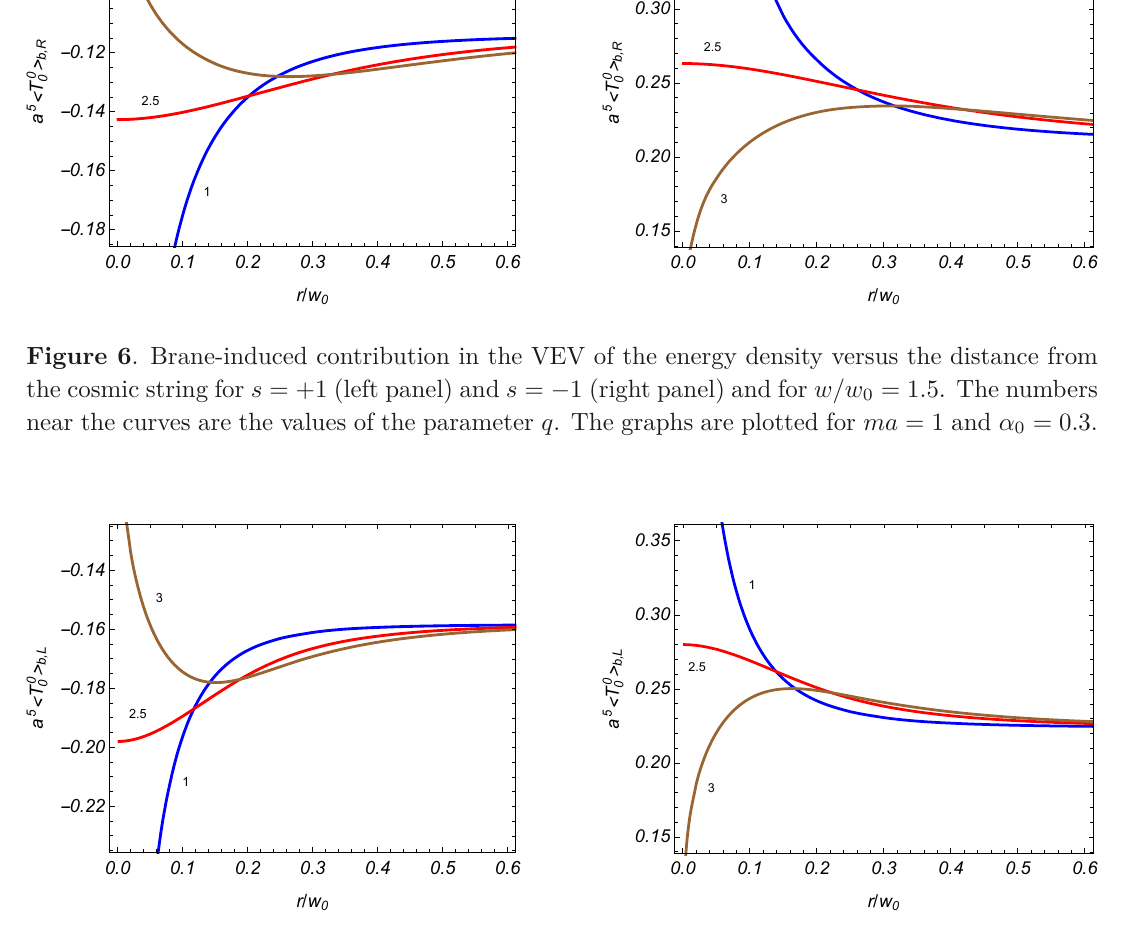
Figure 7 . The same as in figure 6 for the L-region with w/w 0 = 0 .